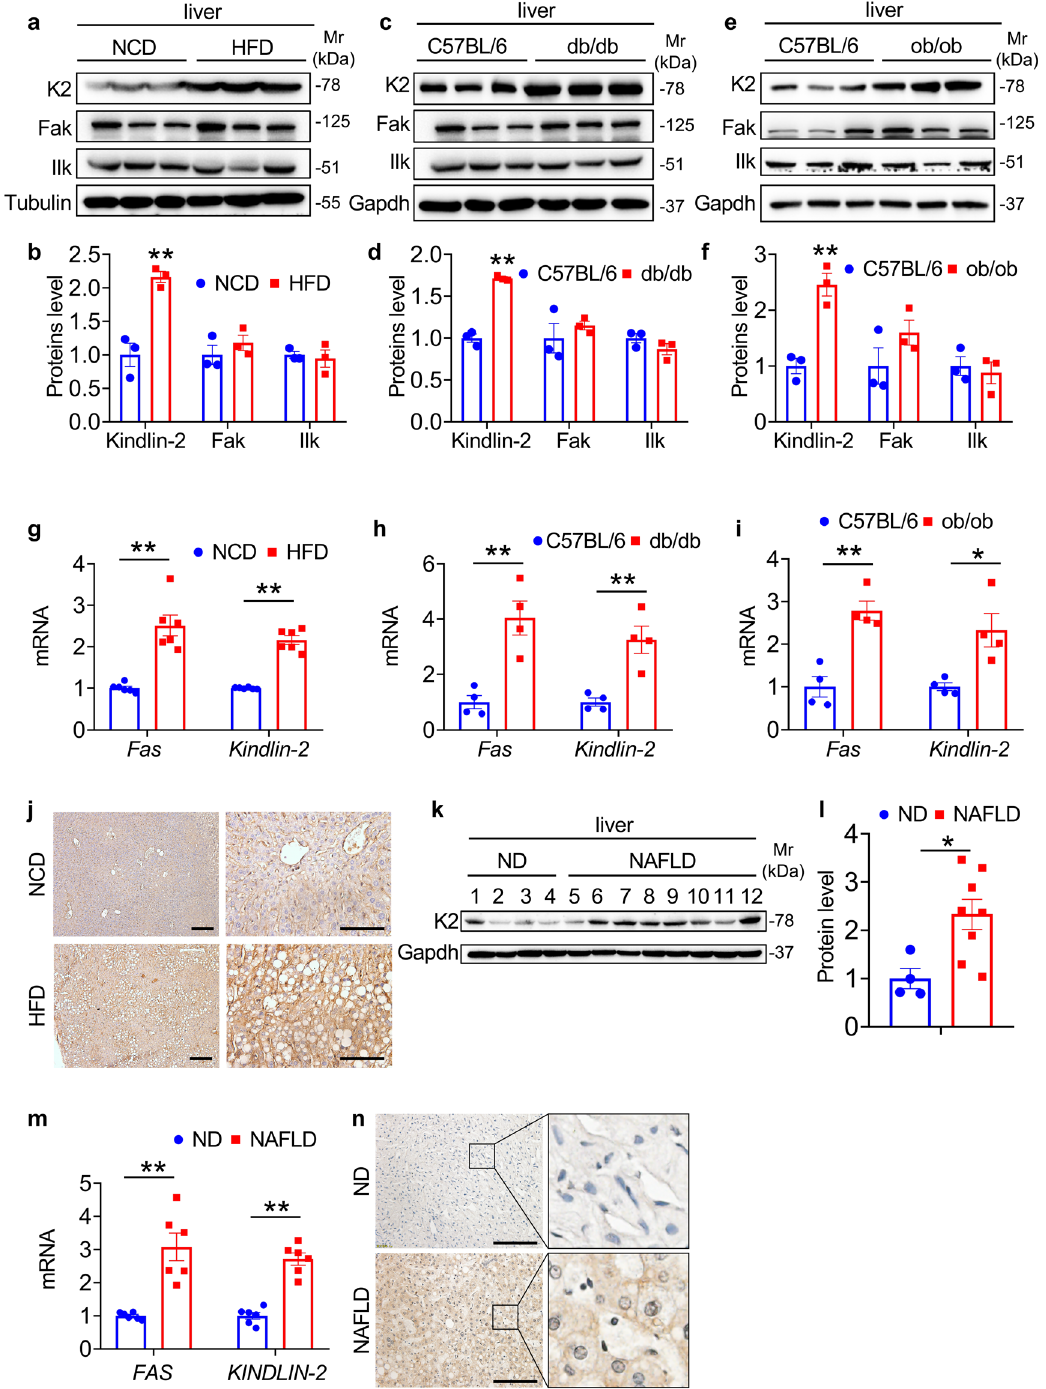
(Fig. 2r). In terms of fi brosis, the qRT-PCR analysis showed that mRNA expression of pro fi brotic genes, including Col1a1 , Tgf- β 1 , Ctgf , and α -Sma , was signi fi cantly decreased in Het relative to control mice (Fig. 2s). We further performed the glucose toler- ance test (GTT) and insulin tolerance test (ITT) and revealed that, when compared with control mice, Het mice exhibited improved glucose tolerance and insulin sensitivity (Fig. 2t – w). To assess whether Kindlin-2 knockdown (KD) in hepatocytes affects the basal metabolism and energy expenditure (EE), we performed metabolic cage experiments in HFD-fed control and Het